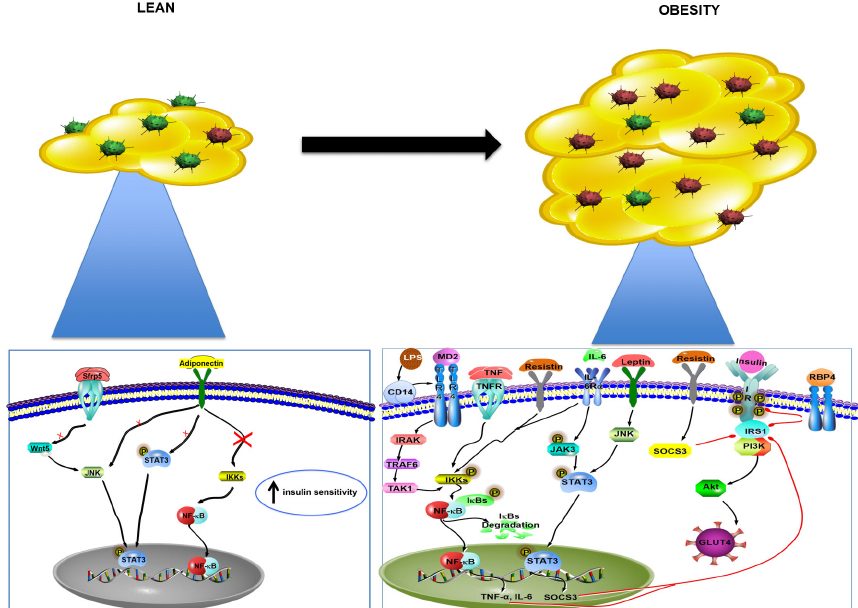
FIGURE 1 - Mechanisms involved in insulin resistance and inflammation present in obesity RBP4, retinol binding protein-4; TNF-α, tumor necrosis factor-α; IL, interleukin; MCP-1, monocyte chemotactic protein-1; SFRP5, secreted frizzled-related protein 5; LPS, lipopolysaccharide; TLR-4, toll-like receptor 4; JNK, c-jun amino (N)-terminal kinase; STAT3, signal transducer and activator of transcription 3; NF-κB, nuclear factor kappa B; IKK, I kappa B kinase; IRS-1, insulin receptor substrate-1; IR, insulin receptor; TRAF1, tumor necrosis factor receptor-associated factor 1; GLUT4, translocation of glucose transporter 4; SOCS-3, suppressor of cytokine signaling protein-3; TRAF, tumor necrosis factor receptor-associated factor; IRAK, interleukin 1 receptor-associated kinase; PI3K, phosphoinositide 3-kinase; JAK, janus kinase; TAK, transforming growth factor (TGF)-activated kinase β; CD14, cluster of differentiation-14; MD2, Myeloid differentiation